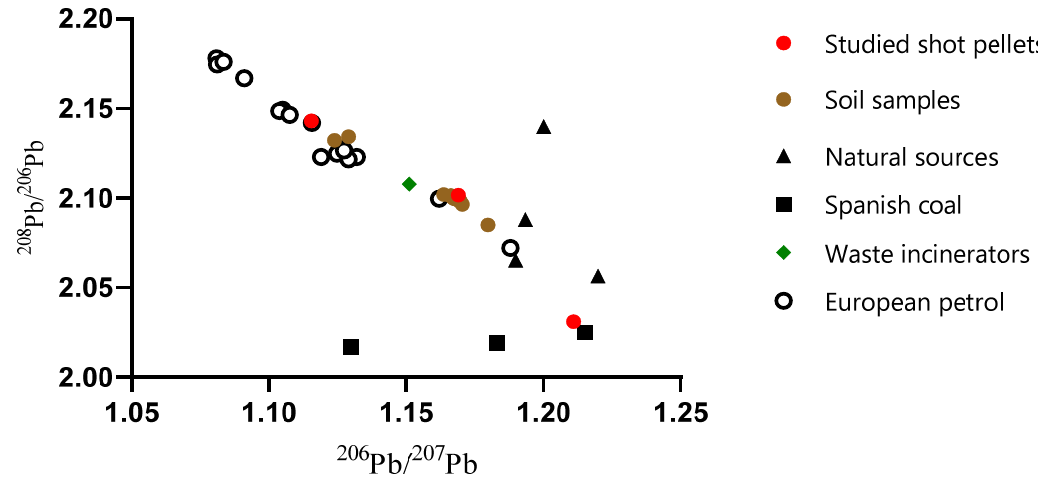
Figure 1. Scatter plot for 208 Pb/ 206 Pb versus 206 Pb/ 207 Pb of lead isotope ratios for different environ- mental components in the vicinity of the study area. Data from [27–32].